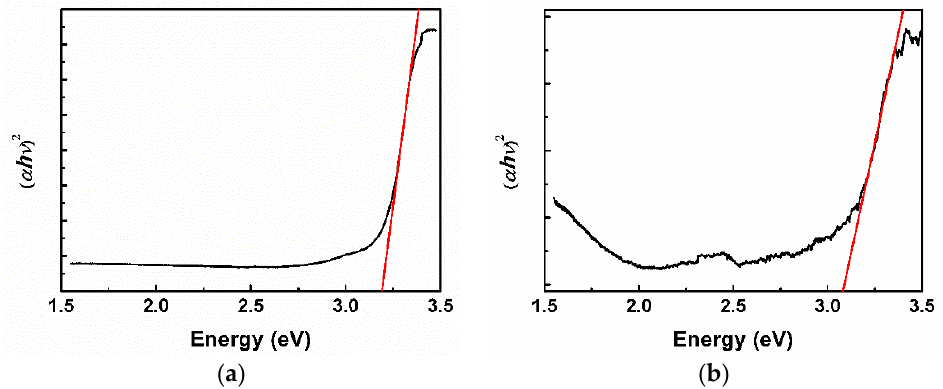
Figure 5. ( αhν ) 2 vs. photon energy spectra for the ZnO thin films grown on the ( a ) quartz glass and ( b ) sapphire (001) substrates, respectively.